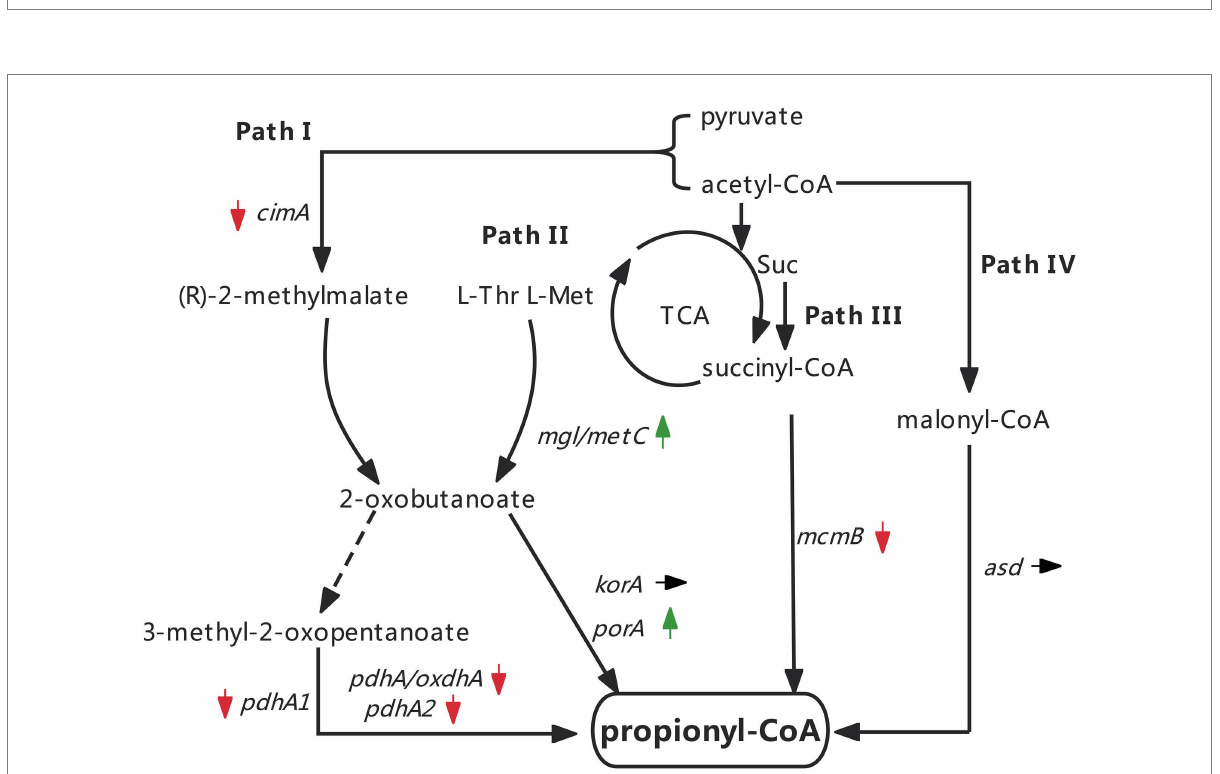
FIGURE 7 Changes of key genes expression in four pathways under the silkworm excrement exposure (Green arrow indicates up-regulation; red arrow indicates down-regulation; black arrow indicates no